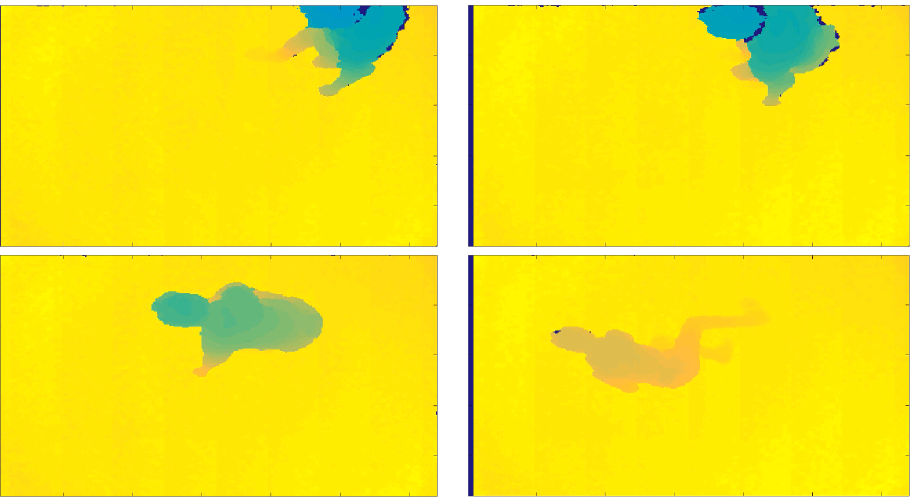
Figure 8. Fall phase of the FSRIFRWK sequence simulated by ES 11, where the person was not recognized. The dot is not present in the